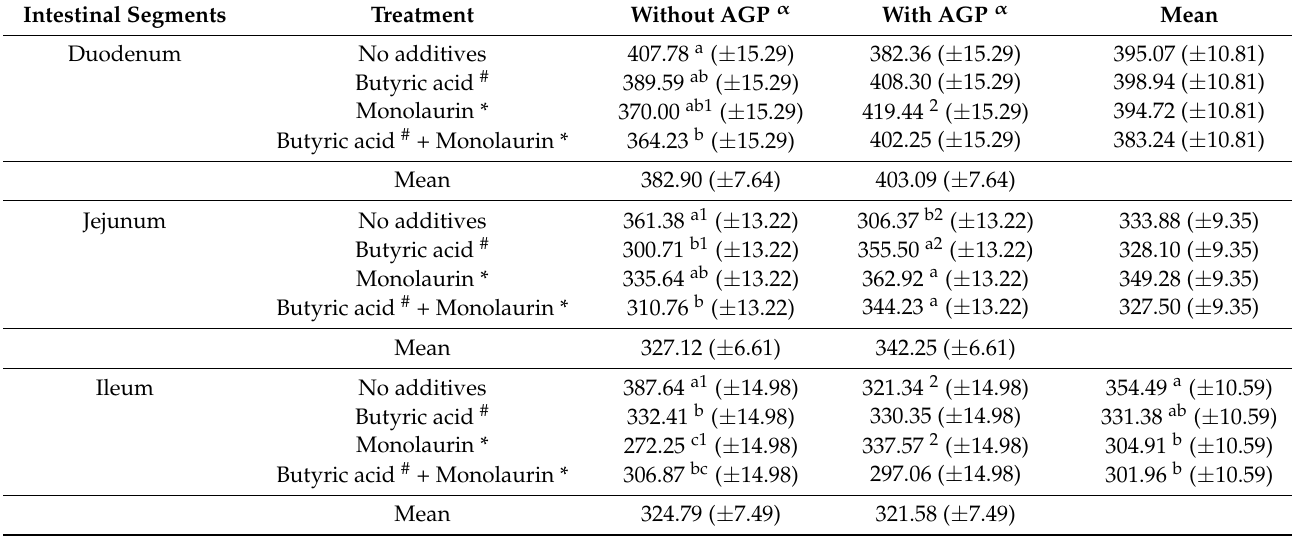
Table 6. The effect of the butyric acid and α -monolaurin, with and without the inclusion of antibiotic growth promoters, on crypt depth ( µ m) of the duodenum, jejunum and ileum of broilers at 20 days of age ( ± standard error of the mean). Intestinal